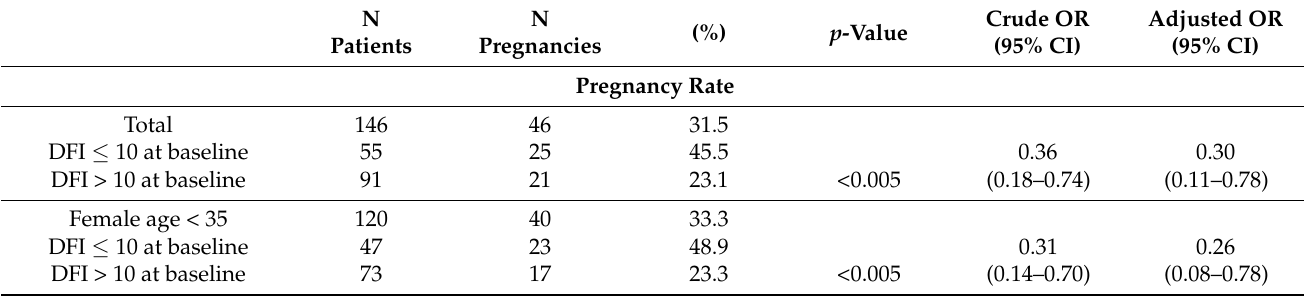
Table 5. Pregnancy rate per patient in relation to baseline DFI. All couples received between 1–3 IUI treatments. The pregnancy rate was significantly higher for couples where the male DFI was ≤ 10 at